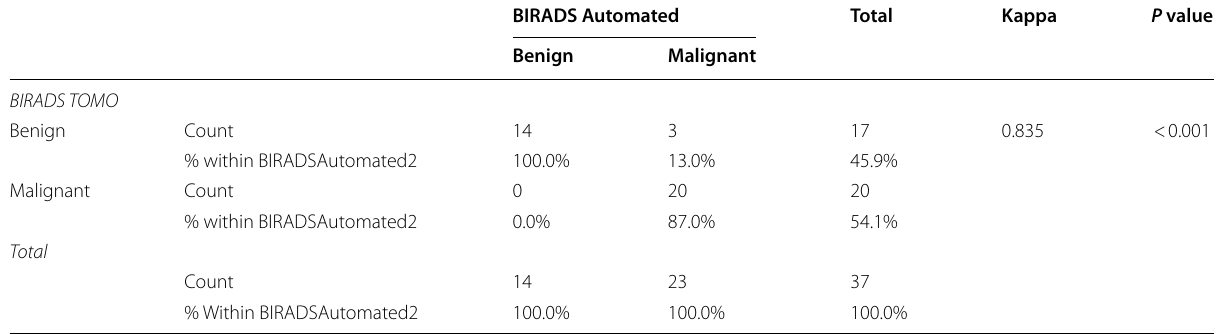
BIRADS Automated